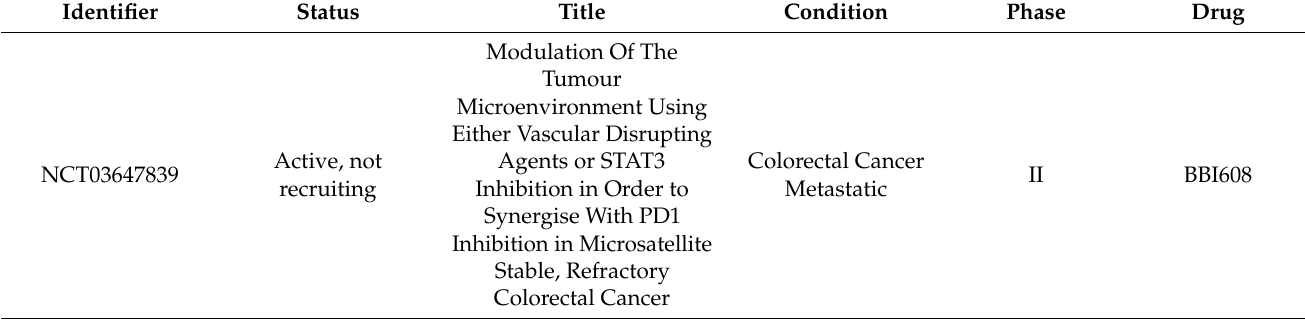
main or STAT3 dimerization, (2) upstream tyrosine kinase inhibitors, (3) STAT3 pathway oligonucleotides, (4) inhibitors of STAT3–DNA binding, and (5) mimics of STAT3 negative regulators [32]. There is a number of STAT3 inhibitors with promising efficacy in preclinical studies, which have entered clinical trials (Table 1) [10]. These STAT3 inhibitors include small peptides and molecules, peptide mimics, oligonucleotides, and siRNA anti-STAT3 compounds. Specifically, STAT3 inhibition is mainly focused on the STAT3 coiled-coil, SH2, and DNA-binding domains [10,35]. Table 1. Clinical trials of CRC patients including STAT3 inhibitors